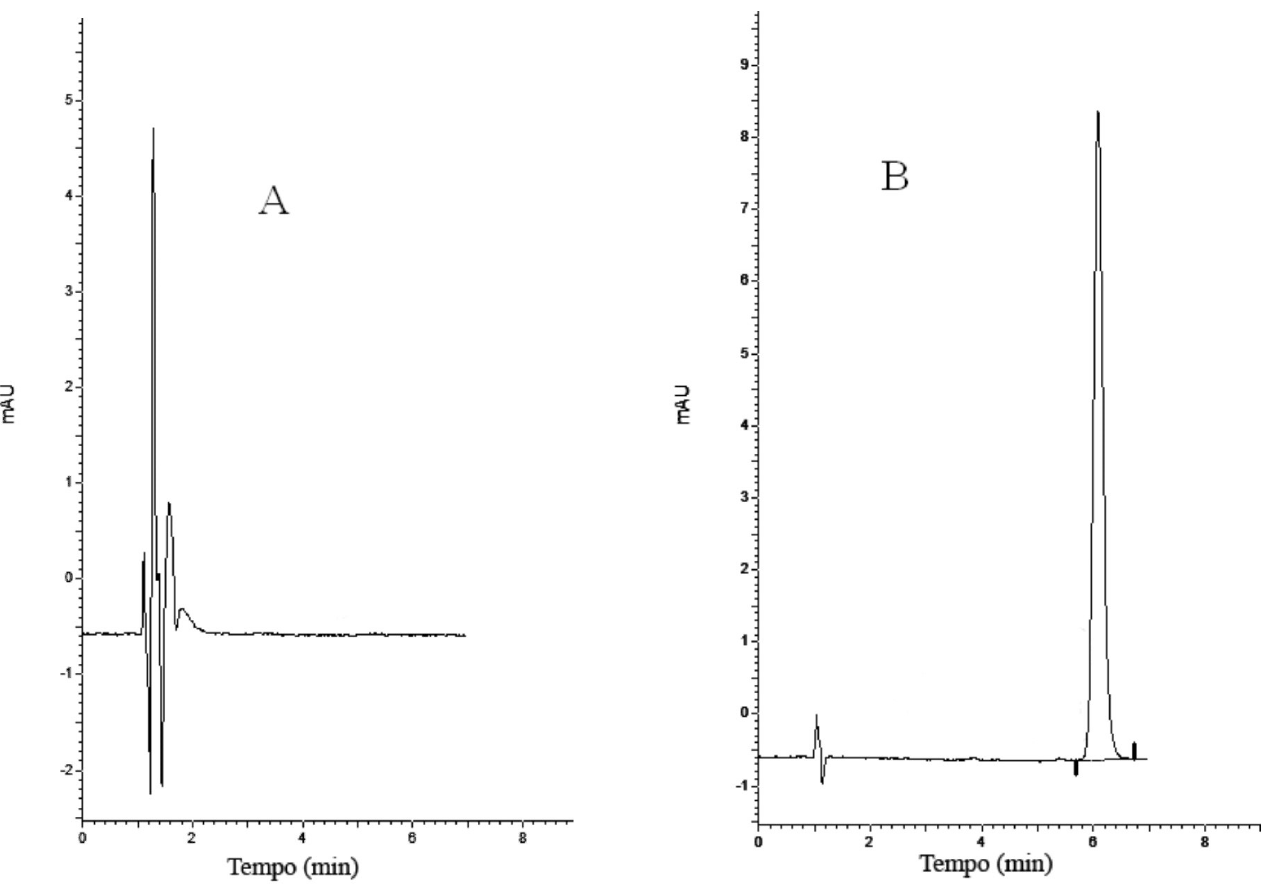
FIGURA 2 - Cromatogramas da análise de microcápsulas de alginato/quitosana incorporadas em gel Natrosol ® sem fármaco (A) e com ácido retinóico disperso em óleo de babaçu (B). As análises foram realizadas em cromatógrafo SPD 10 AVP com detector UV-VIS a 350 nm, bomba LC-10 ADVP e programa LC-10 (Shimadzu, Kyoto, Japão). Coluna C18 de fase reversa (Gemini ® , Phenomenex) 150 x 4,6 mm (5μm) e fase móvel constituída de metanol e ácido acético a 1% (85:15 v/v) com vazão de 1,8 mL/ minuto e volume de injeção de 20